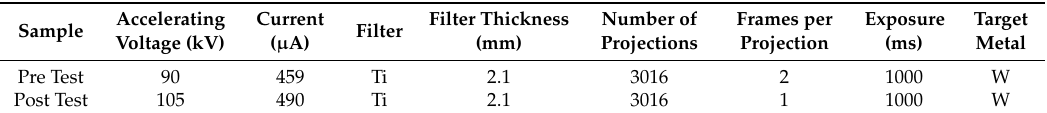
Table 2. Computed tomography (CT) scan parameters of EBM small punch disc specimen before and after testing.